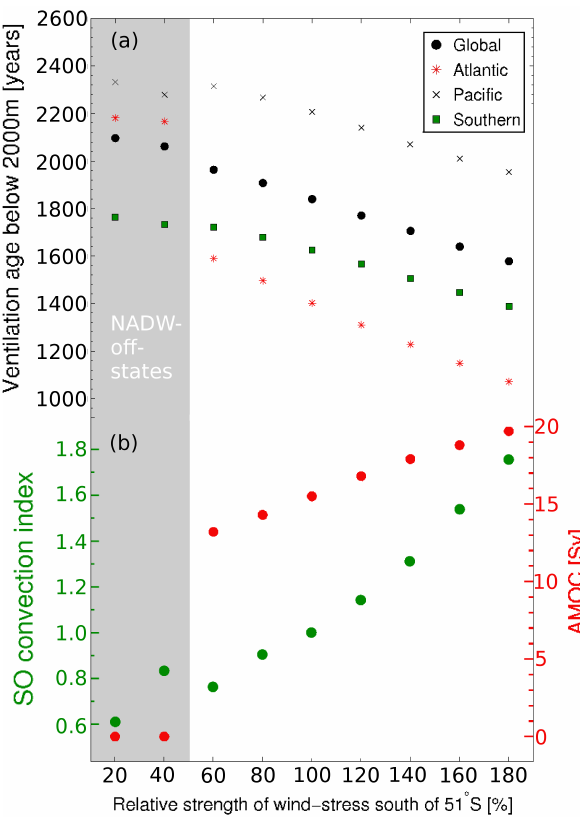
Fig. 5. (a) Ventilation age in different ocean basins as a func- tion of the SO wind stress amplitude. Ventilation age is calculated from simulated 14 R -signatures in the ocean below 2000m depth. 14 R is treated here as an ideal age tracer in the sense that it is transported only by ocean circulation and the atmospheric signa- ture is held constant ( 14 R atm =1.0). Ventilation age is calculated (cid:16) (cid:17) 14 R ln where λ =1/8267yr − 1 is the de- as τ basin = 1 atm / 14 R basin λ cay constant for 14 C and 14 R basin is the average 14 R -signature in the respective basin. (b) Southern Ocean convection index and At- lantic Meridional Overturning Circulation (AMOC) versus SO wind stress. The SO convection index is proportional to the number of model grid cells in the SO participating in convective